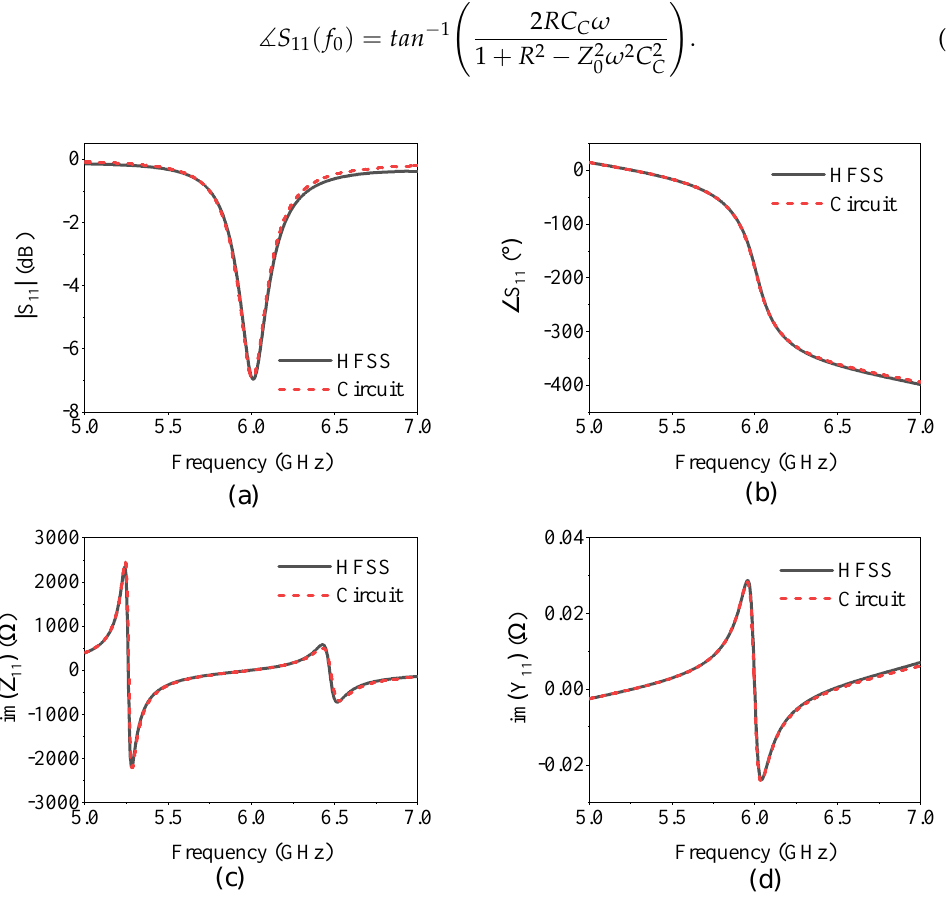
Figure 4. Comparison between full-wave simulations of CSRR and its circuit model in ( a ) | S 11 | , ( b ) (cid:93) S 11 , ( c ) im ( Z 11 ) , and ( d ) im ( Y 11 )